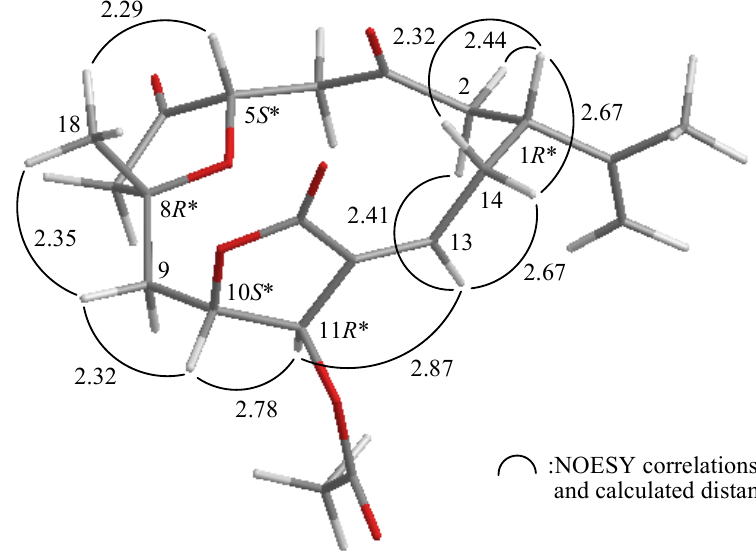
Figure 3. The computer-generated model of 1 using MM2 force field calculations and the calculated distances (Å) between selected protons with key NOESY